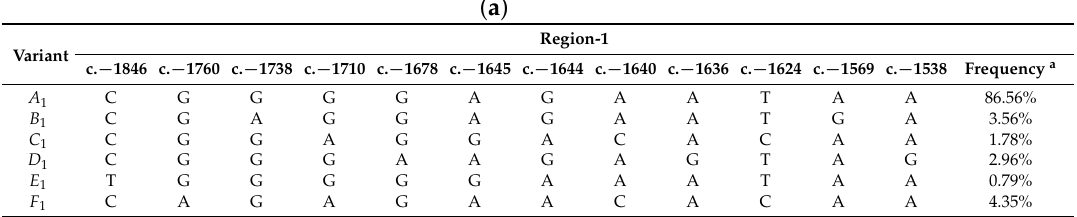
Table 2. Single nucleotide polymorphisms (SNPs) found in ovine UCP1 and their overall frequencies in the sheep. ( a ) Region-1, ( b ) Region-2, ( c ) Region-3, ( d ) Region-5, ( e )